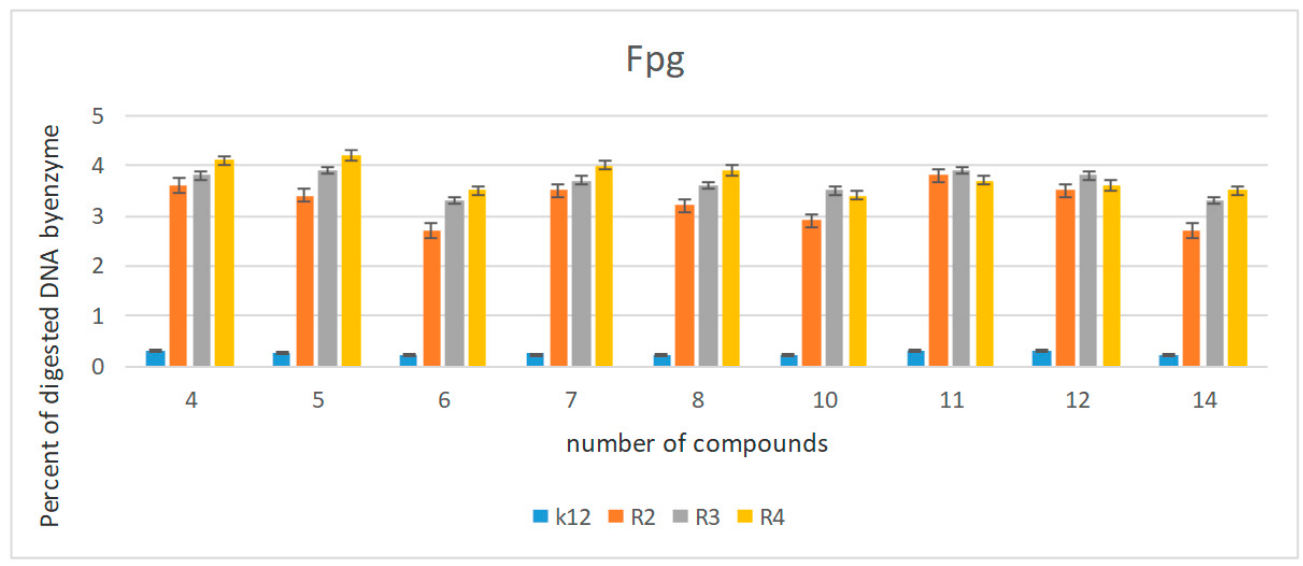
Figure 7. Percentage of plasmid DNA recognized by Fpg enzyme ( y -axis) with model bacterial, K12, and R2–R4 strains ( x -axis). All analyzed compounds numbered were statistically significant at <0.05 (see Table 2). The data are shown in Supplementary Materials Figure S2. Table 2. Statistical analysis of all analyzed compounds by MIC, MBC, and MBC/MIC; <0.05 *, <0.01 **, <0.001 ***. No. of Samples 4, 5, 6 7, 8, 10 11, 12, 14 Type of Test K12 ** ** ** MIC R2 ** ** ** MIC R3 ** ** MIC R4 K12 R3 R4 MBC K12